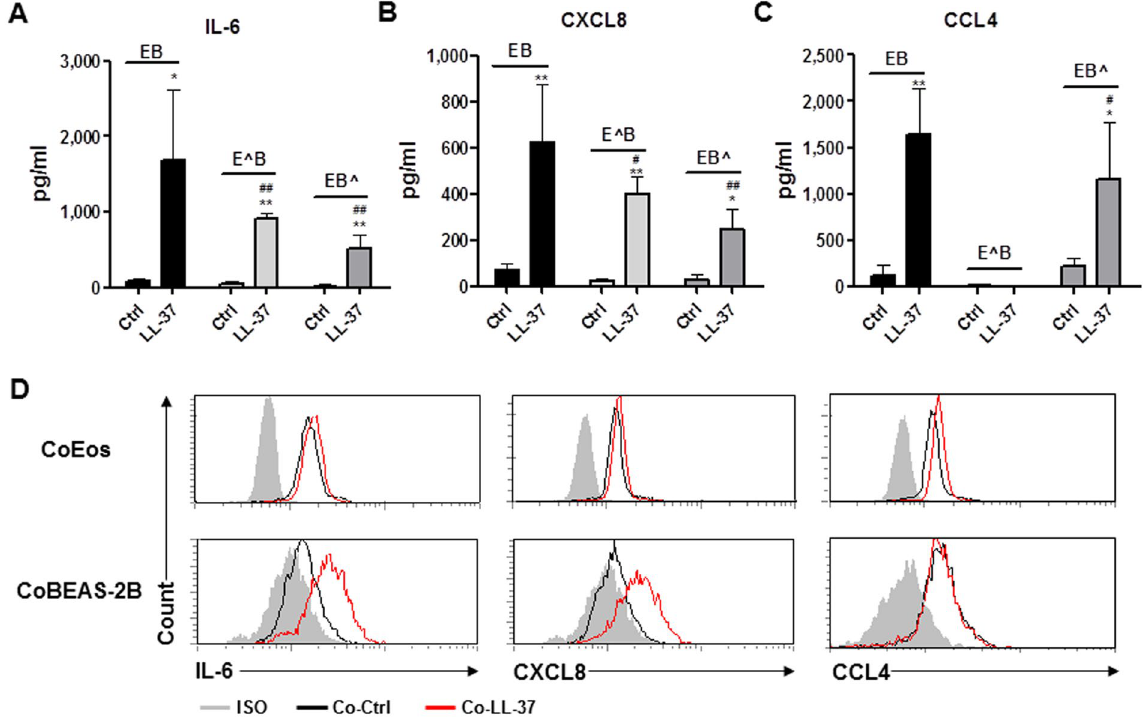
Figure 4. Sources of cytokine/chemokine expressions in co-culture of eosinophils and BEAS-2B cells under the stimulation of LL-37. Human eosinophils (3 × 10 5 ) and BEAS-2B cells (1 × 10 5 ) were treated with or without paraformaldehyde before being cultured together with or without 10 µ g/ml LL-37 for 20 h. Release of IL-6 ( A ), CXCL8 ( B ) and CCL4 ( C ) in culture supernatant was determined. ( D ) 3 × 10 5 eosinophils and 1 × 10 5 BEAS-2B cells were co-cultured with or without 10 µ g/ml LL-37 for 16 h, followed by the incubation with 10 µ g/ml brefeldin A for further 4 h. Intracellular staining of IL-6, CXCL8 and CCL4 were then performed. Representative histograms of intracellular staining of IL-6, CXCL8 and CCL4 are shown from triplicate independent experiments showing essentially similar results. E: unfixed eosinophils; E^: fixed eosinophils; B: unfixed BEAS-2B cells; B^: fixed BEAS-2B cells. Results are shown as arithmetic mean plus SD of triplicate independent experiments. * P < 0.05, ** P < 0.01 when compared between the denoted group and the corresponding control groups without treatment. # P < 0.05 , ## P < 0.01 when compared between the denoted groups and the corresponding control groups of unfixed cells with LL-37 treatments.